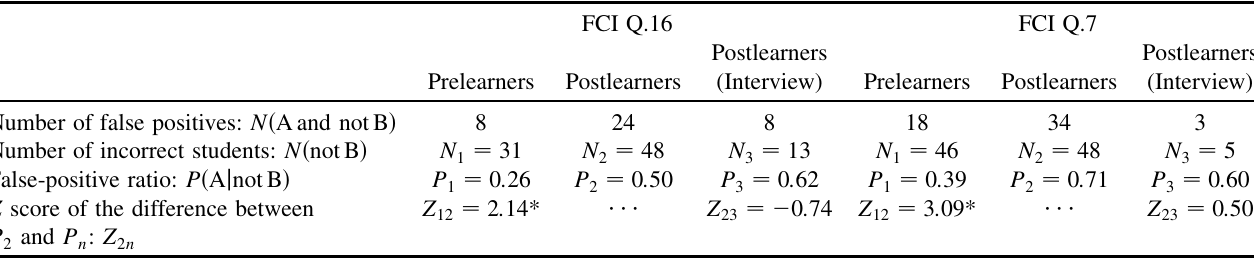
TABLE III. False-positive ratios and Z scores for FCI Q.16 and Q.7.